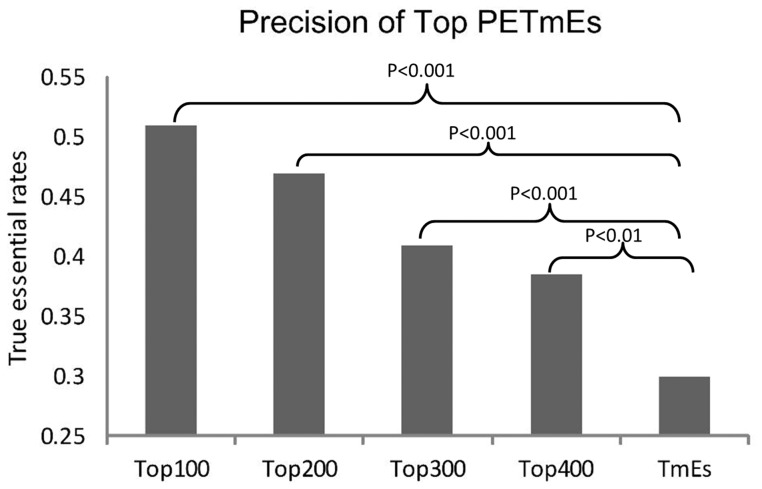
Enrichment of true essential genes using different thresholds of the confidence score.